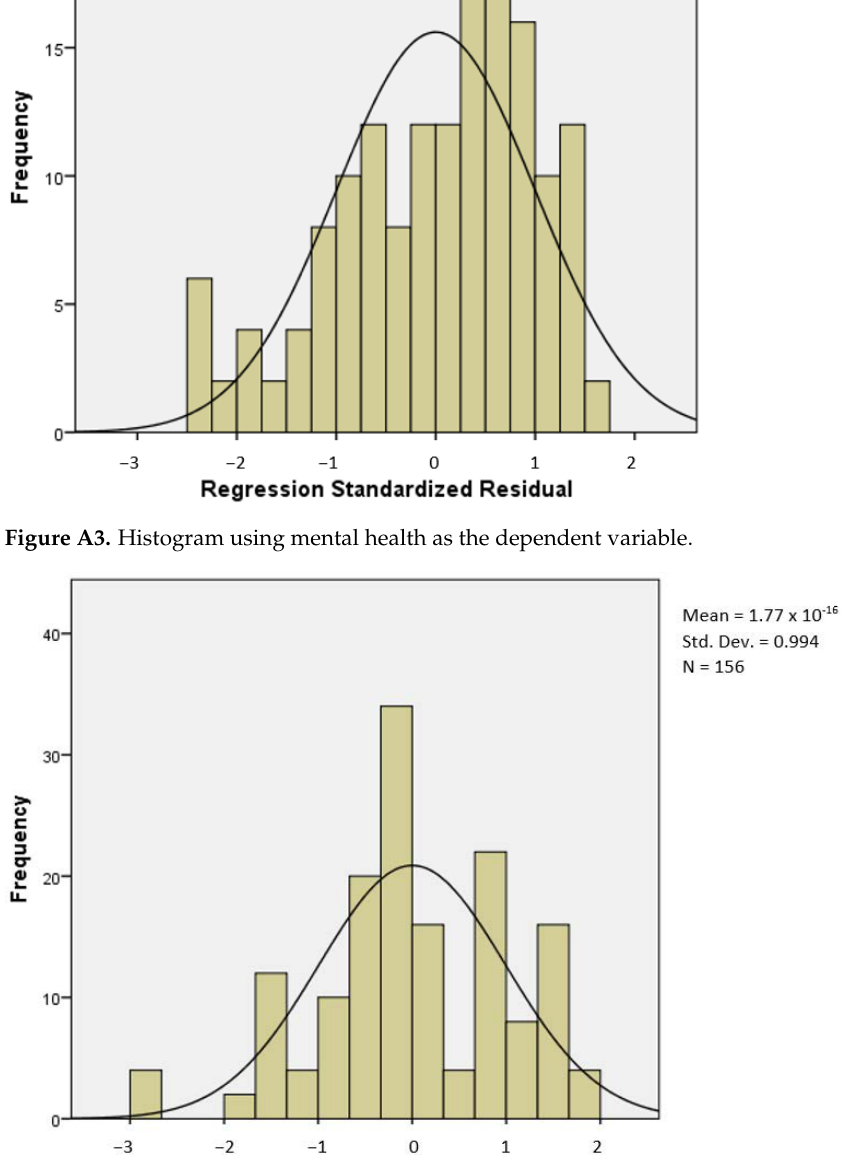
Figure A4. Histogram using social relationships as the dependent variable.